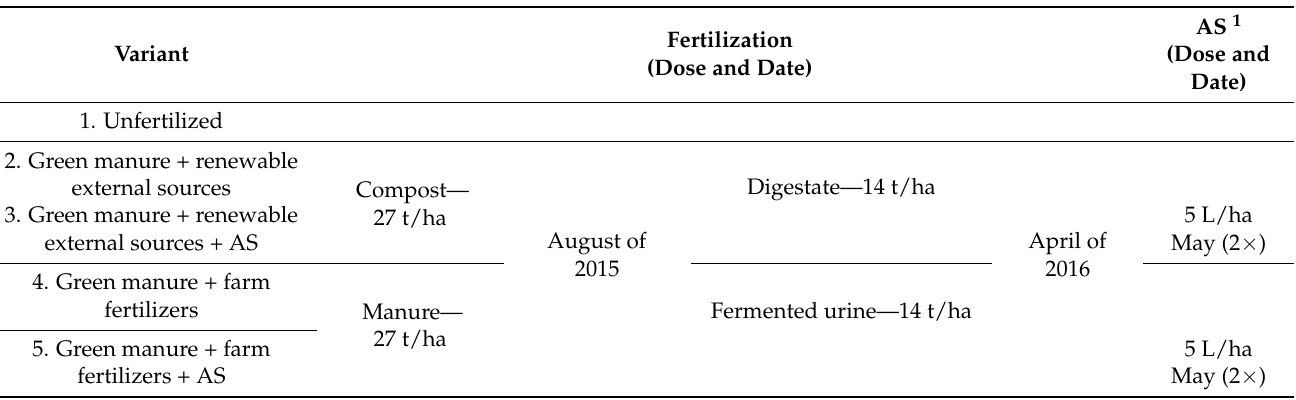
Table 4. Fertilization of potatoes (2016).